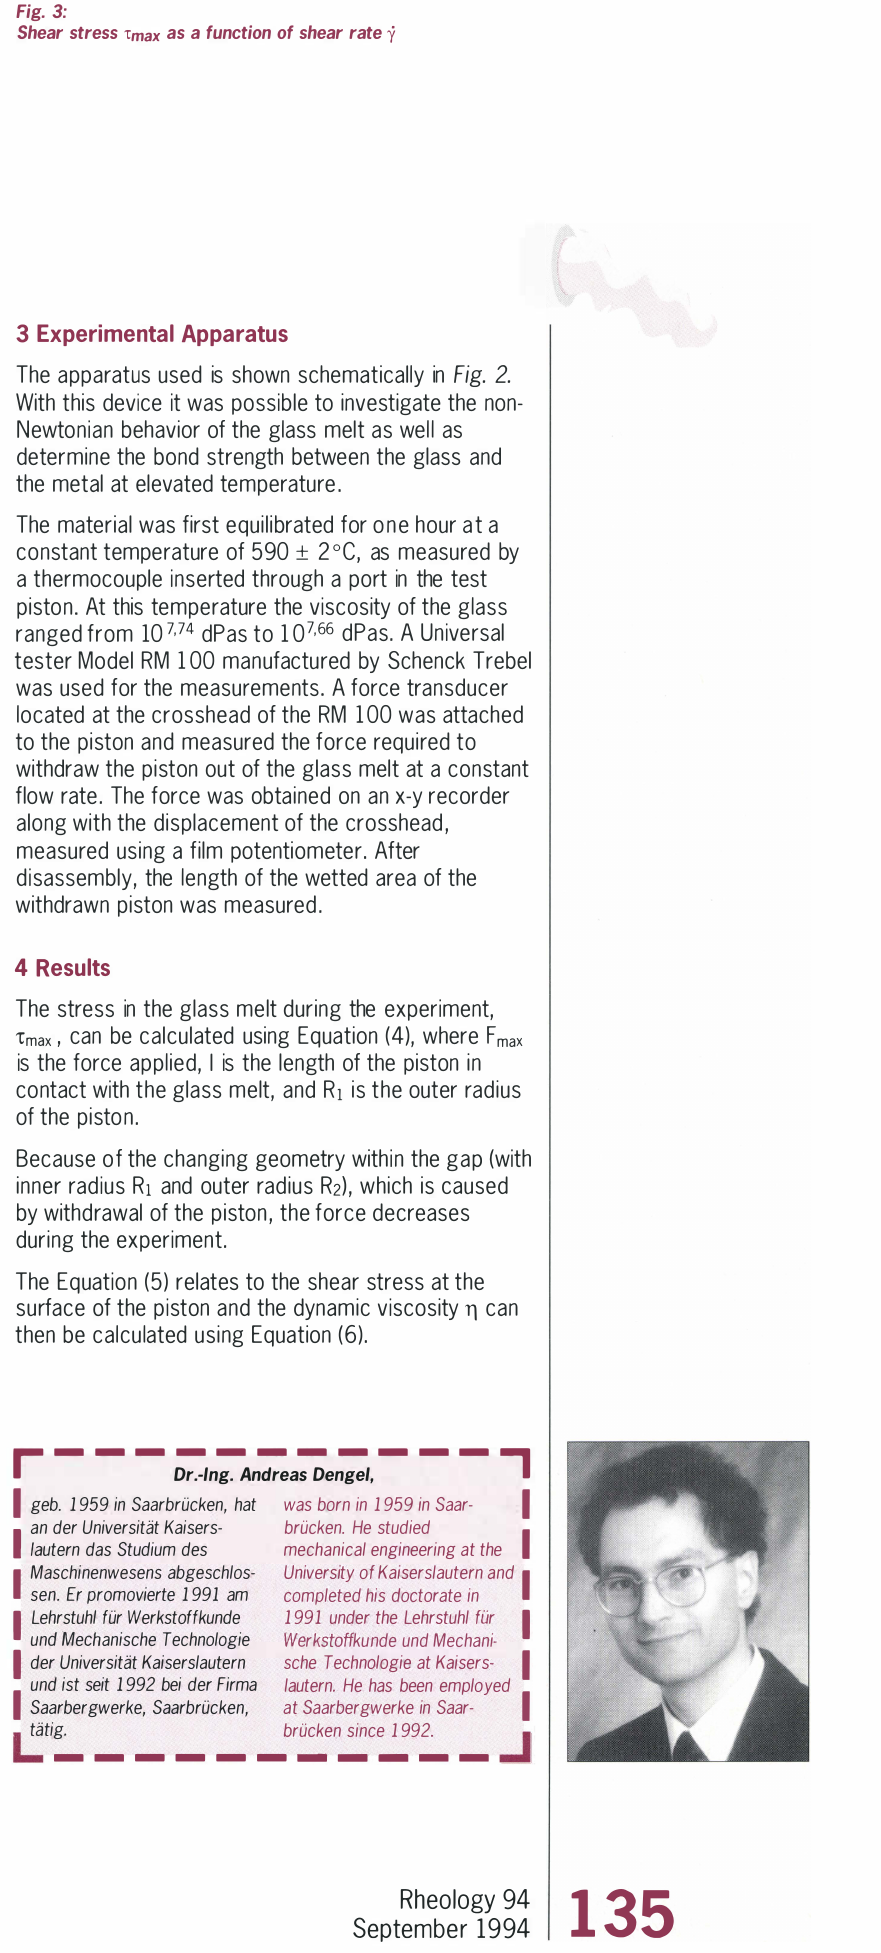
Fig. 3: Shear stress �max as a function of shear rate